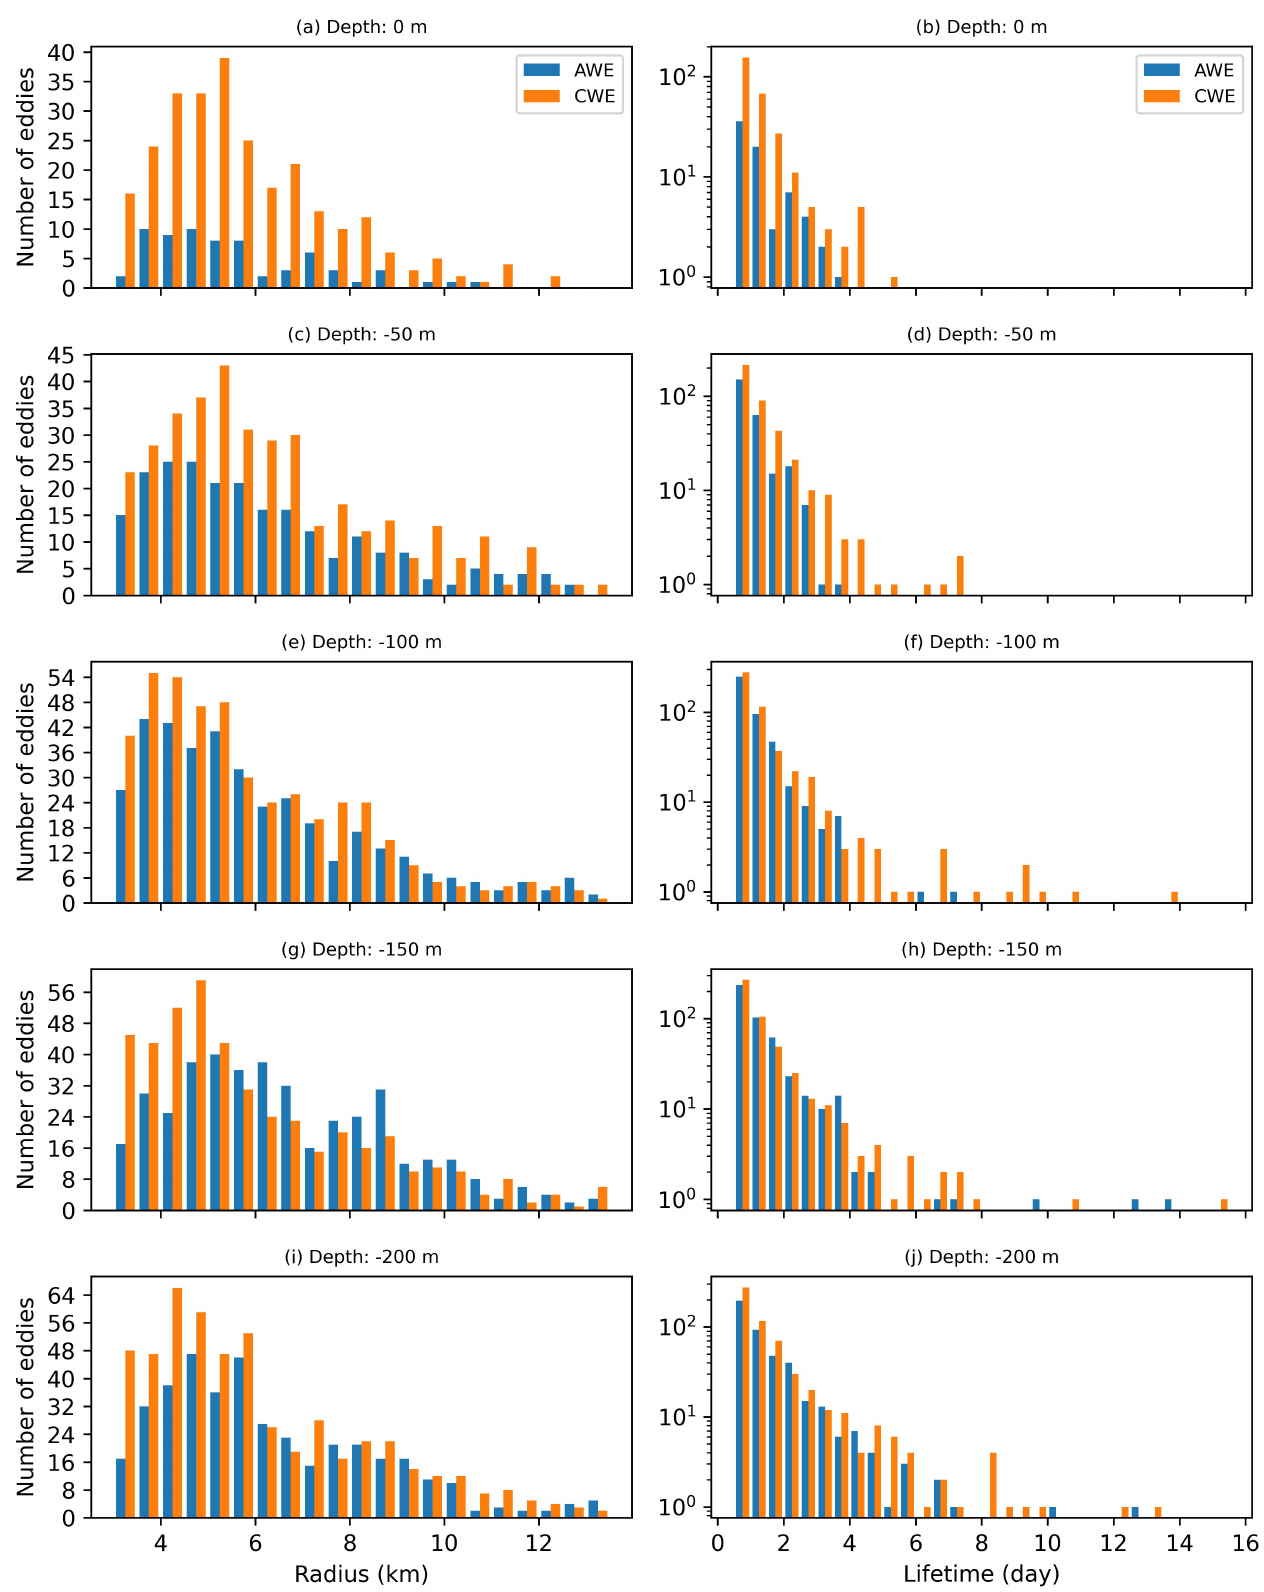
Figure 6. Distributions of the maximal radii ( left ) and lifetimes ( right ) of CWEs versus AWEs detected between 0 and 200 m in the XA in 2009.